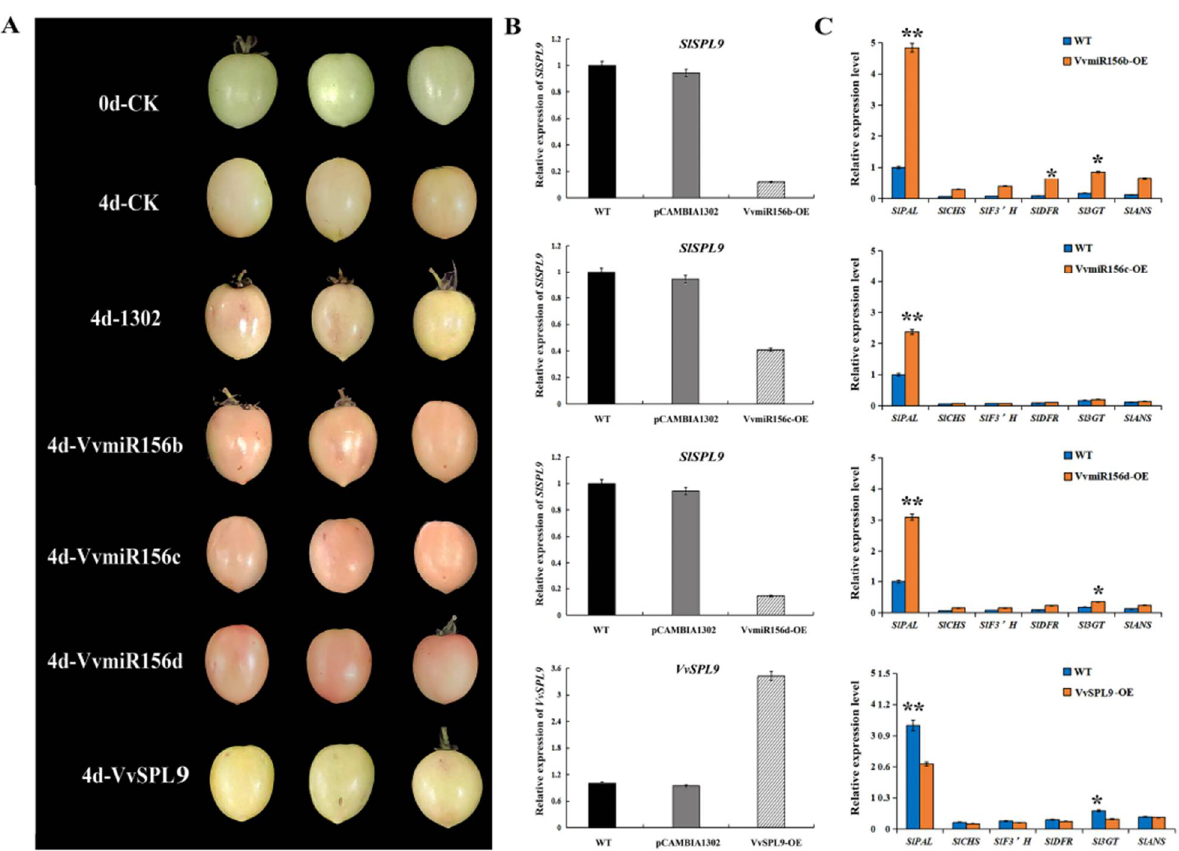
Figure 8. Transient overexpression of VvmiR156b/c/d and VvSPL9 in tomato. ( A ) VvmiR156b/c/d-OE and VvSPL9 -OE fruits four days after infiltration. ( B ) The expression of SPL9 in tomato. ( C ) VvmiR156b/c/d-OE and VvSPL9 -OE effects on the expression of anthocyanin-related genes in tomato. ANOVA test was used to identify significant differences, asterisks indicate statistically significant differences at ( * p < 0.05; ** p < 0.01 ) as determined by the Student’s t -test.